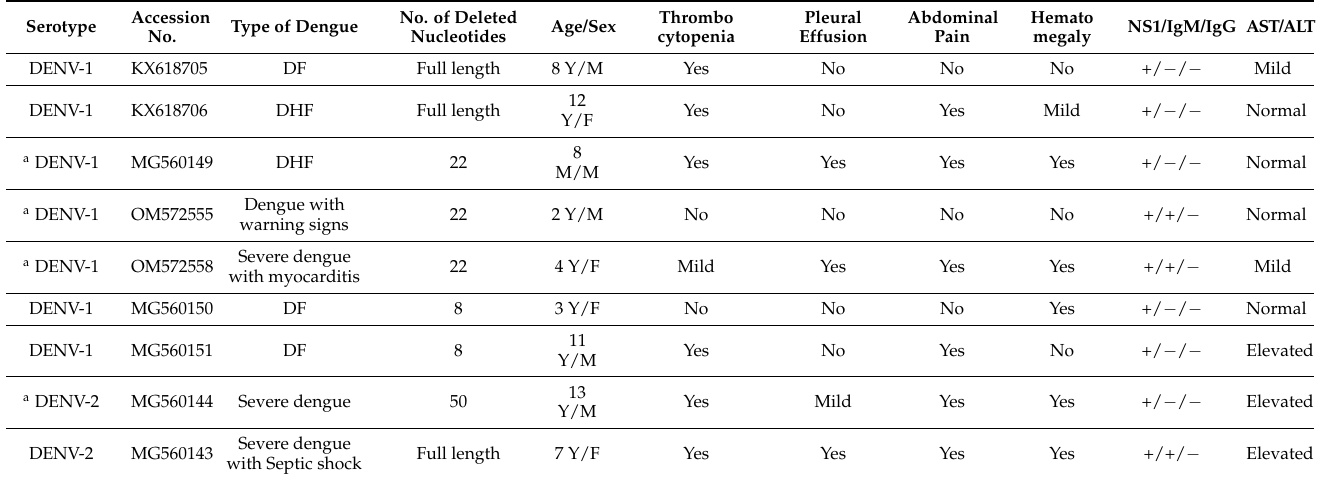
Table 1. Clinical characteristics of DENV-1 and 2 samples with full length and deletions in 3 (cid:48) UTRs.